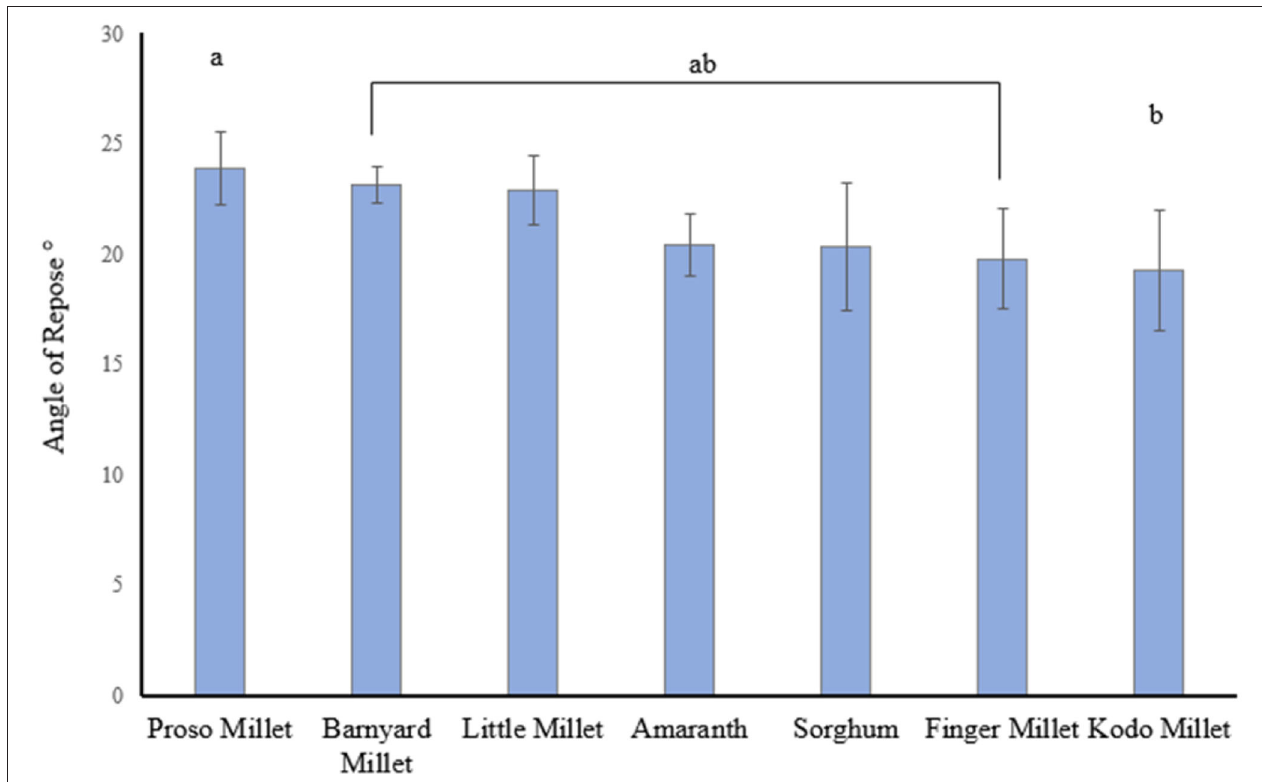
FIGURE 2 | Angle of Repose for Ancient Grains. Mean values not connected by the same letters are significantly different (Tukey’s HSD, P < 0.05). TABLE 3 | Color, shape, and water activity of ancient grains. Ancient